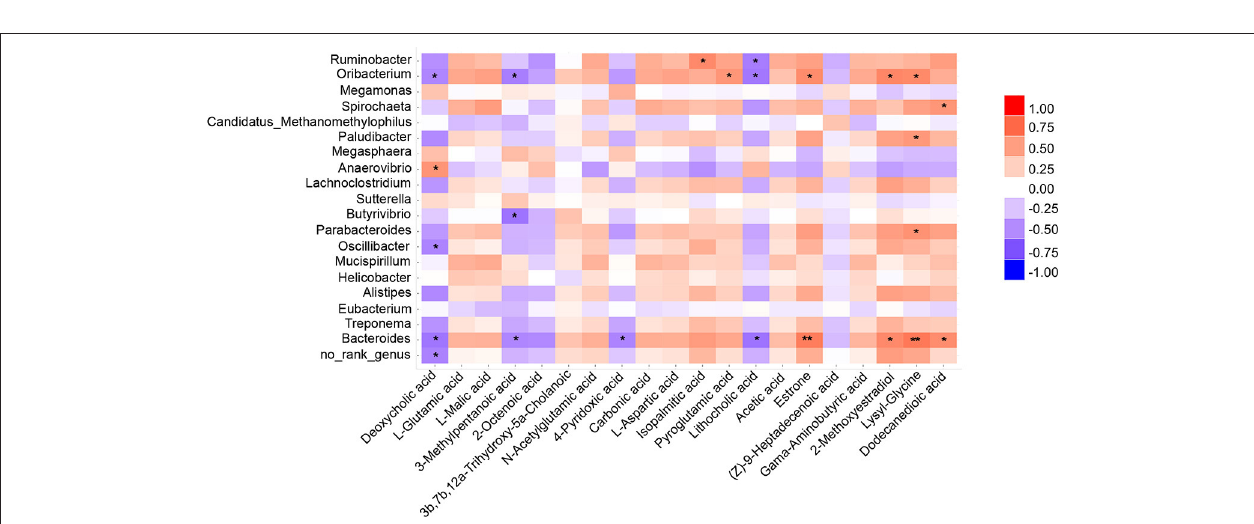
FIGURE 5 | Correlations between plasma metabolite and gut microbiota. Heatmap indicated that some microbes were positively correlated with plasma metabolites and some were negatively correlated with metabolites. * P < 0.05, ** P < 0.01. or indirectly by eCB, including AEA, 2-arachidonylglycerol (2- AG), N-acylserotonins, and some N-acylethanolamines.